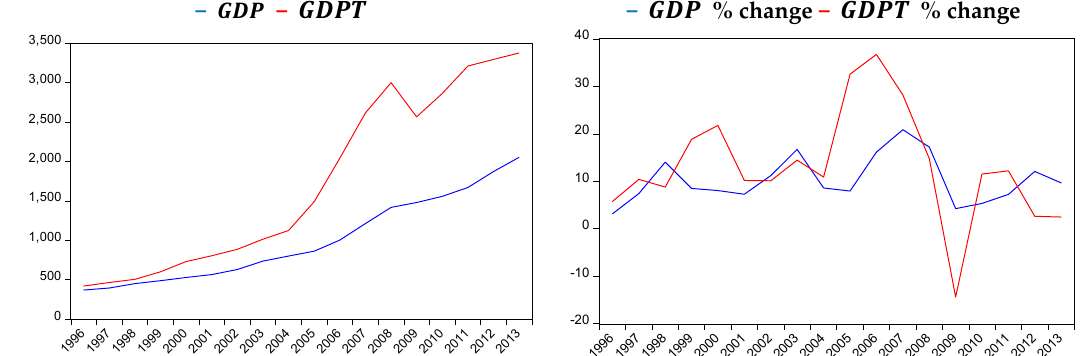
Figure 1. Level and growth rates of Non-oil GDP and Total GDP.